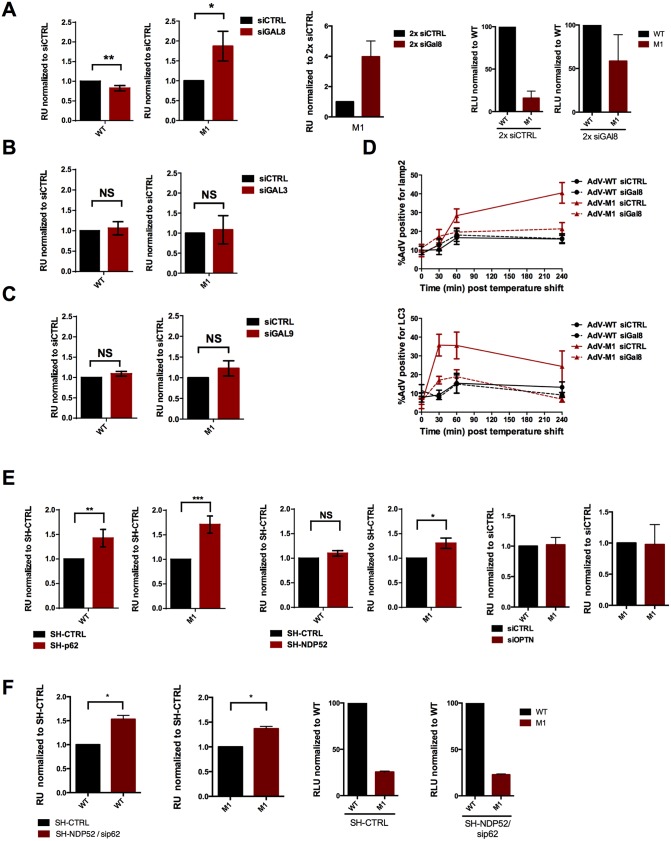
M1 restriction is mediated by Gal8.(A) Left panel: U2OS cells were depleted with siRNAs specific for galectin8. Cells were transduced with WT or M1 as indicated and the relative transduction efficiency was calculated for control depleted cells (black bars) or galectin depleted cells (red bars). Middle panel: Relative transduction efficiency of the M1 virus following two rounds of siRNA depletion. Right panel: The same data as in the middle panel showing the level of M1 infectivity rescue compared to the normalized WT infectivity upon treatment. Each experiment was done in triplicate (B) Experiment essentially done as in (A) except that galectin 3 was depleted. (C) Experiment essentially done as in (A) except that galectin 9 was depleted. (D) HeLa cells were transfected twice with control or galectin8 specific siRNAs followed by infection with WT or M1 viruses and fixed at different time points after infection. Quantification of AdV colocalizing with LC3 (top panel.) and Lamp1 (bottom panel) was performed and is shown as percentage of colocalization for each virus and condition according to the legend. (E) Left panel: Cells were depleted with SH-RNA specific for p62. Specific or control depleted cells were transduced with WT or M1 as indicated and the relative transduction efficiency was calculated for control depleted cells (black bars) or p62 depleted cells (red bars). Middle panel: Experiment essentially done as for p62 except that SH-RNA was directed against NDP52. Right panel: Experiment essentially done as for p62 except that SH-RNA was directed against optineurin (OPTN). (F) Left panel: Cells were depleted with SH-RNA specific for NDP52 followed by transfection with siRNA against p62. Double depleted or control depleted cells were transduced with WT or M1 as indicated and the relative transduction efficiency was calculated for control depleted cells (black bars) or p62 depleted cells (red bars). Middle panel: The same data as in the left panel showing the level of M1 infectivity rescue compared to the normalized WT infectivity upon treatment.